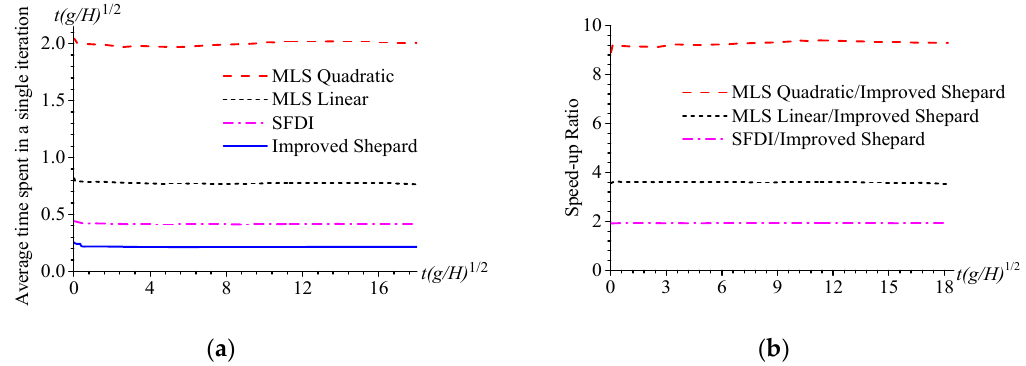
Figure 12. Comparison of the computational efficiency between the improved Shepard and other methods for solitary wave impact on fixed seawalls. ( a ) Average time spent in a single iteration, ( b ) a sped-up comparison.